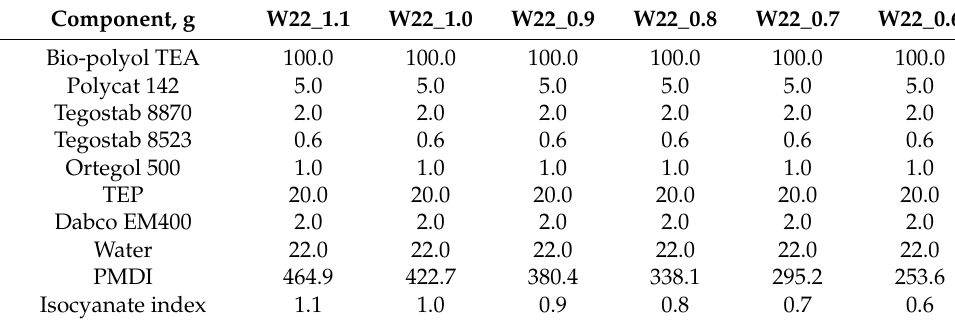
Table 2. The formulations of the foams with different isocyanate